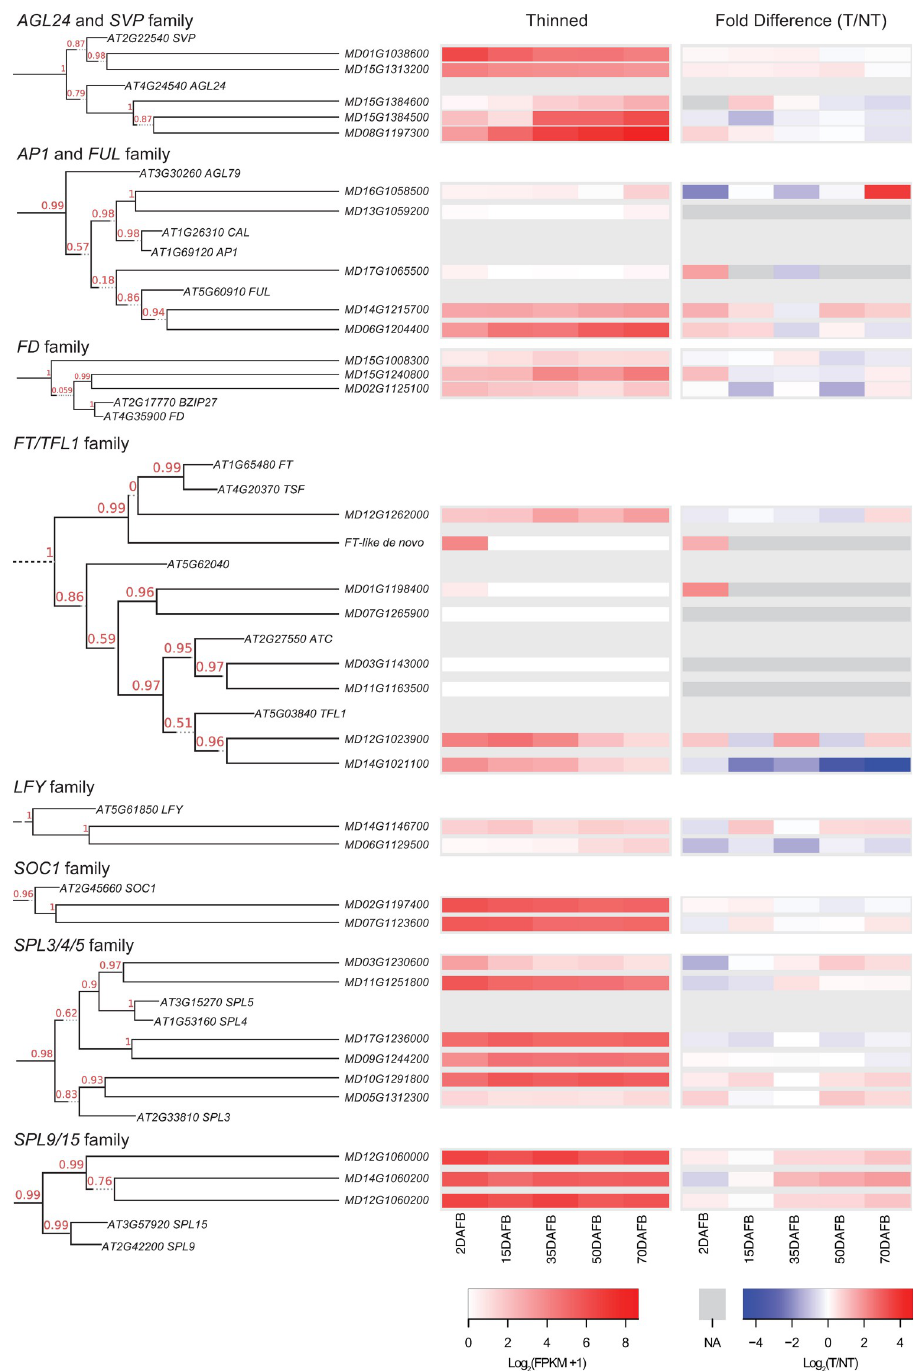
Fig 7. Phylogenetic trees and expression heatmaps for homeologous flowering genes. The phylogenetic trees are as shown in Fig 3. Heat maps represent expression at each sample date. In the left heatmap panel, expression values (FPKM +1) from thinned apices were log 2 transformed. In the right heatmap panel, fold difference in expression between thinned (T) and non-thinned (NT) apices were log 2 transformed. Cells for which no expression value was available are shown in dark gray